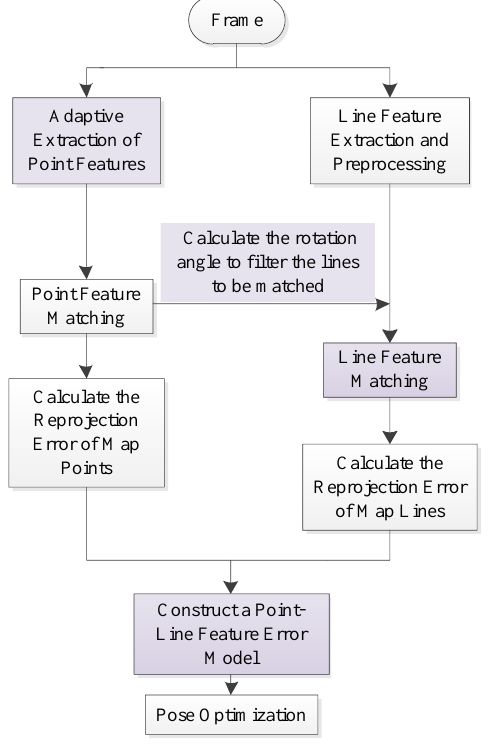
Figure 4. The front-end framework diagram based on the improved point-line features